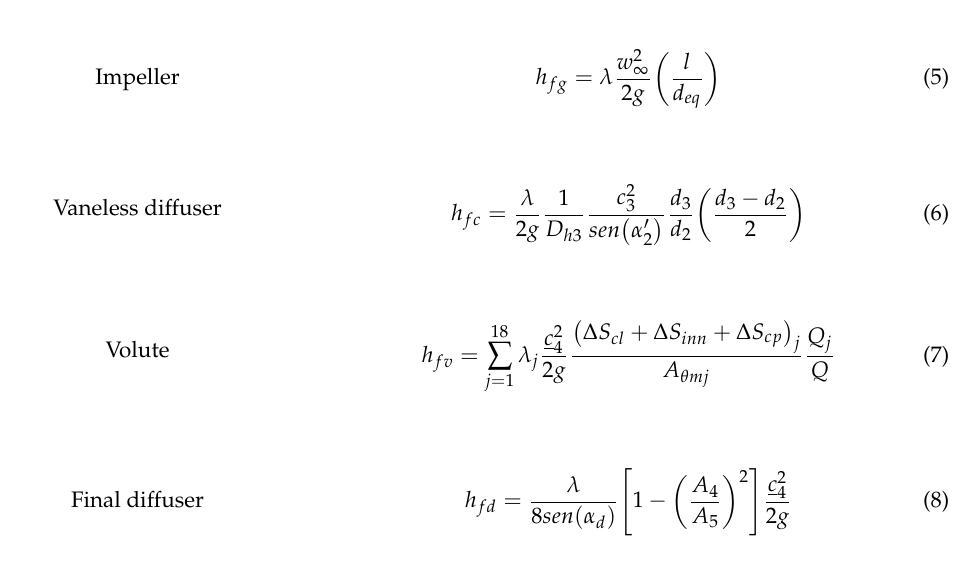
Table 1. Friction losses in pump